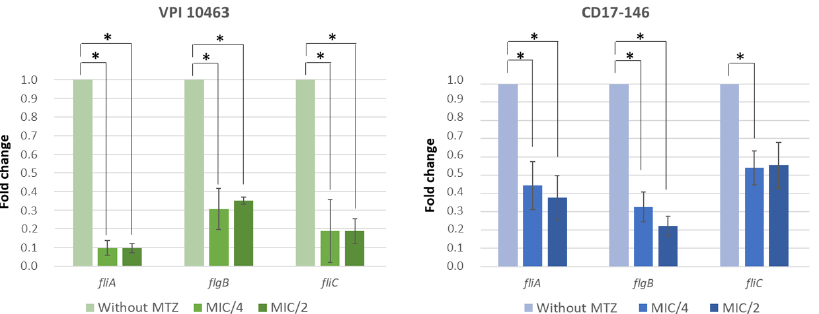
Figure 4. Expression of flagellar genes of VPI 10463 (VPI, green) and CD17-146 (146, blue) at subinhibitory concentrations of MTZ. Bacteria were grown in BHI-SG broth without or with MTZ at MIC/4 and MIC/2 at 37 °C under anaerobic conditions until OD600 nm reached 0.7. Using qRT-PCR, transcripts levels of fliA , flgB and fliC were measured. MTZ repressed the expression of flagellar genes in the two strains. Data are representative of three independent experiments, each performed in triplicate. The error bars represent standard errors of mean (SEM). Significantly different ( p < 0.05) ratios are indicated by asterisks (Man-Whitney test).